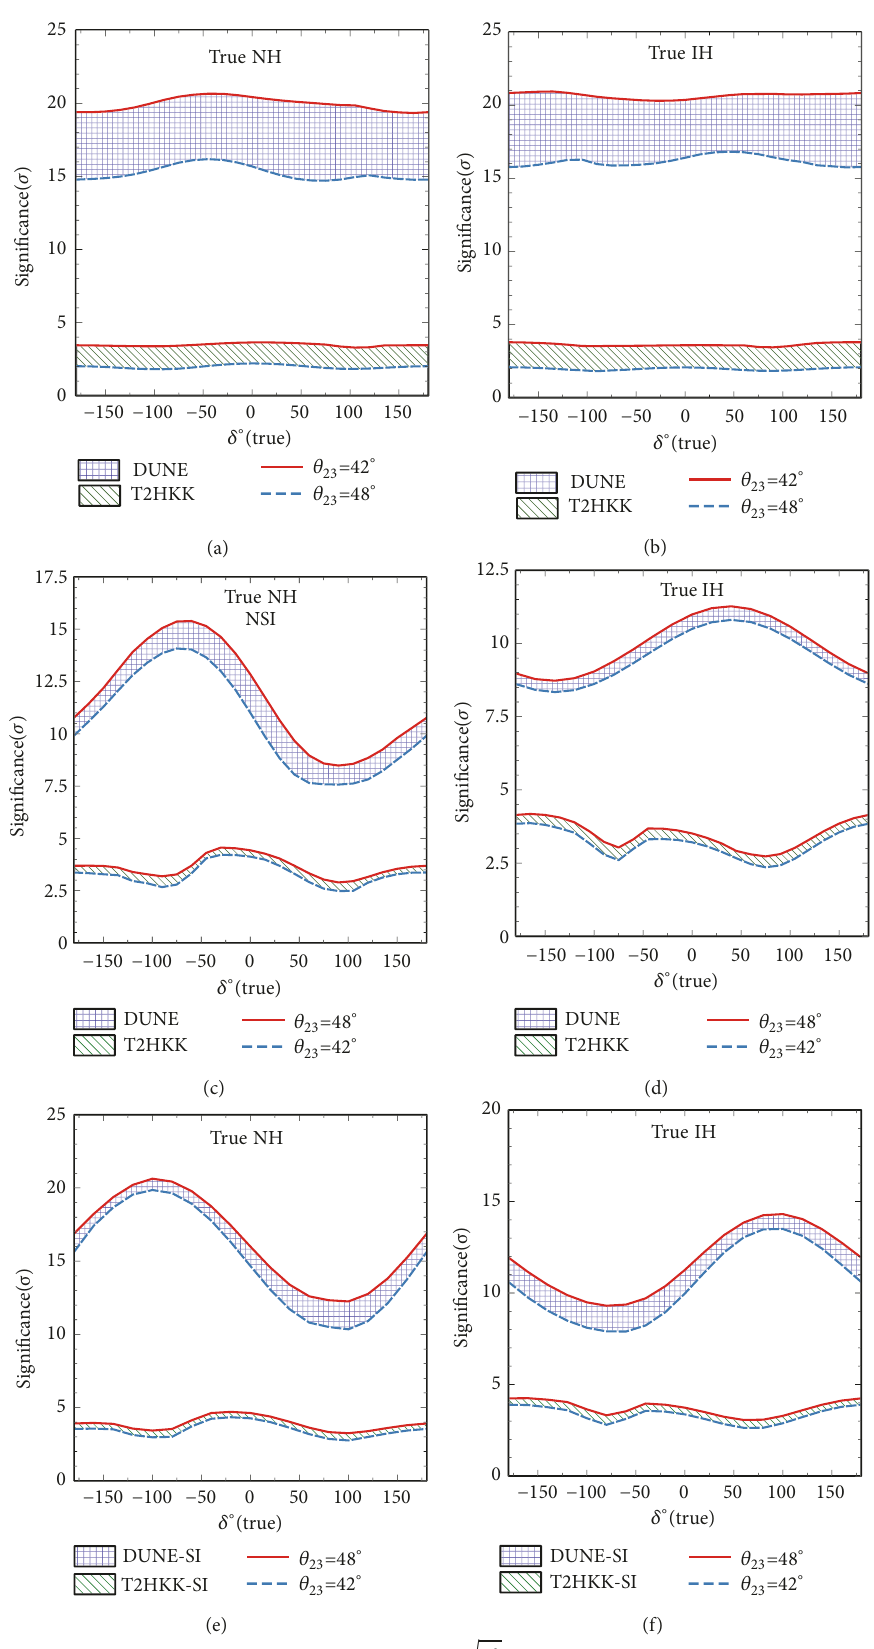
Figure 3: Sensitivity plots for mass hierarchy. The plots for significance ( √𝜒 2 ) as a function of 𝛿(𝑡𝑟𝑢𝑒) with true NH (left panel) and true IH (right panel). The first (second) row describes mass hierarchy sensitivity assuming all ( 𝜖 푒휇 , 𝛿 푒휇 ) NSI parameters nonzero. Figures 3(e) and 3(f) show the sensitivity plots for SI case. The band comes due to variation of 𝜃 23 and boundaries correspond to 𝜃 23 = 42 ∘ and 48 ∘